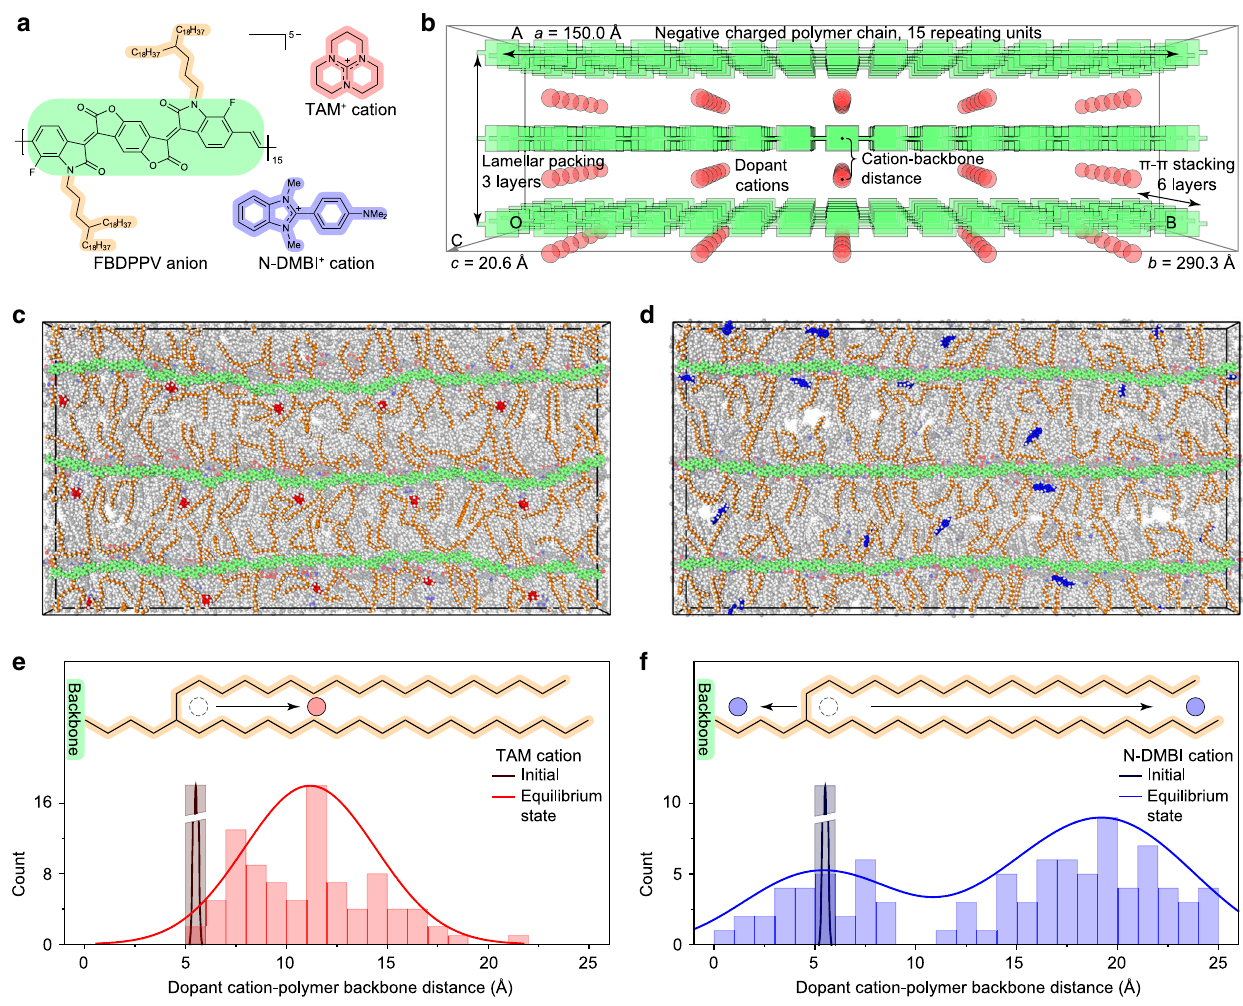
Fig. 2 Cation – side chain interaction prediction. a Chemical structures of FBDPPV anions, TAM + , and N-DMBI + cations. b Schematic diagram of initial supercell for molecular dynamics which contains FBDPPV anions and TAM + (or N-DMBI + ) cations. Polymer alkyl chains are hidden for clearer vision. c , d Equilibrium con fi gurations of n -doped FBDPPV by TAM ( c ) or N-DMBI ( d ). The middle (fourth of six) π – π stacking layer is highlighted for clearer vision. e , f Histogram of distances between dopant cations and polymer-conjugated backbones for TAM-doped FBDPPV ( e ) and N-DMBI-doped FBDPPV ( f ). Notice distance = 0 is polymer backbone and distance = 25 Å is alkyl chain tails. In all the above schematic diagrams, light green is for FBDPPV backbone, orange is for FBDPPV alkyl side chain, and red/blue is for dopant cation. TAM + cation has distinctly weaker interactions with polymer backbones, whereas N-DMBI + cation presents stronger interactions with polymer